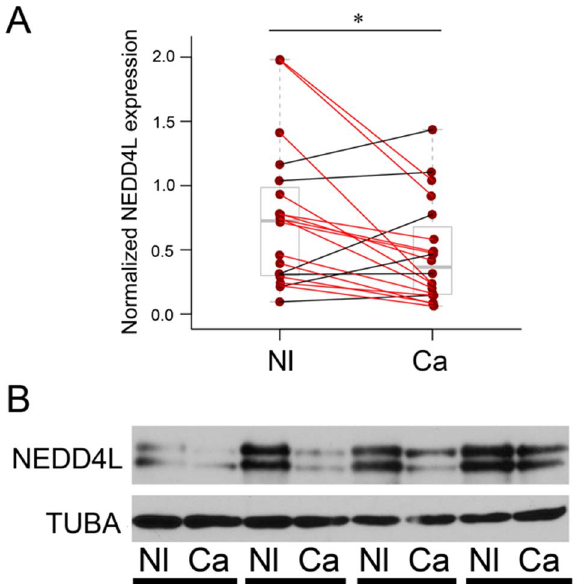
Figure 3. NEDD4L protein levels are down in CRC. (A) NEDD4L levels were determined by western blotting of CRC (Ca) and adjacent normal (Nl) mucosa from twenty individuals. Levels were normalized to TUBA and Nl was compared to Ca. NEDD4L was significantly downregulated ( , 42%) in CRC (*p , 0.05). Data is represented in box and whisker plot format. The lines connecting data points show the relative NEDD4L levels in a given Nl-Ca matched pair. Red denotes decreased NEDD4L levels in Ca, while black denotes an increase. (B) Lysates generated from Nl-Ca matched pairs were blotted for NEDD4L and TUBA. Shown here are four representative pairs.